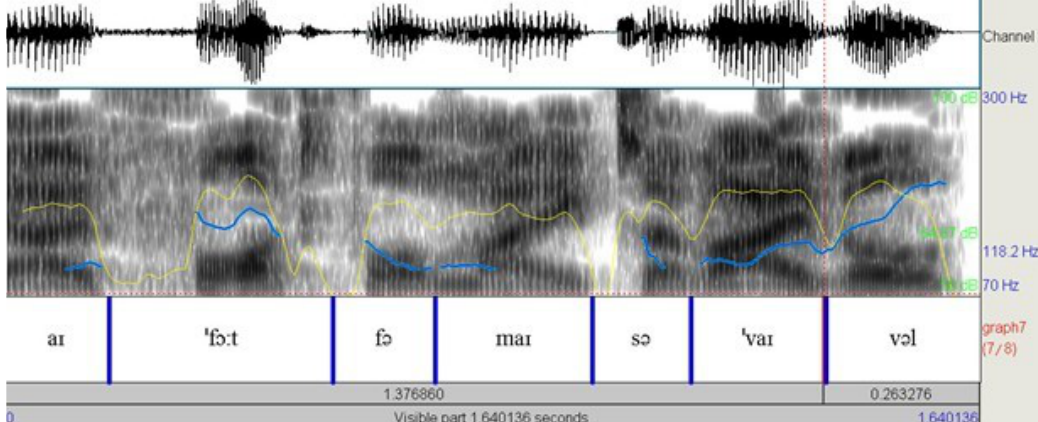
Figure 2 - F0 contour in the utterance produced by a HKE male speaker Note: blue curve indicates F0; yellow curve indicates intensity